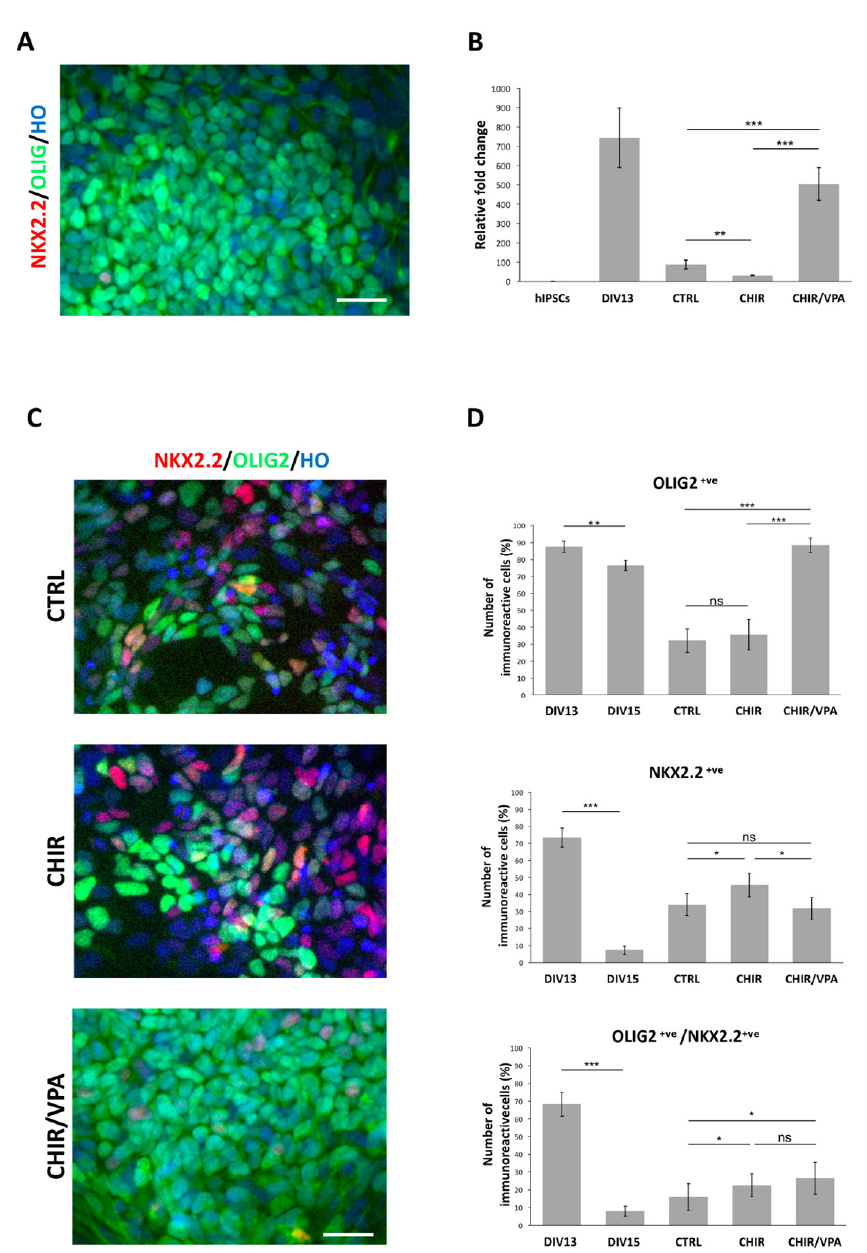
Figure 2. CHIR and VPA treatment allows efficient MNPCs expansion. ( A ) DIV15 MNPCs immunoreactivity for OLIG2 and NKX2.2. Nuclei are stained with Hoechst (HO). ( B ) qPCR analysis for OLIG2 transcript levels in hiPSCs, DIV13 MNPCs and cultures expanded for three passages in CTRL, CHIR and CHIR/VPA conditions. ( C ) Representative pictures showing OLIG2 and NKX2.2 immunoreactivity on cultures expanded for three passages in CTRL, CHIR and CHIR/VPA conditions. Nuclei are stained with Hoechst (HO). ( D ) Graphs reporting the number of OLIG2, NKX2.2 and OLIG2/NKX2.2 double-positive cells (top, central and bottom panel, respectively) in DIV13 and DIV15 MNPCs and cultures expanded for three passages in CTRL, CHIR and CHIR/VPA conditions. The percentage is normalized over the total number of cells assessed by HO staining. Scale bars: 15 μ m. Data are expressed as the means ± STDV ( n = 3 biologically independent experiments). p < 0.05 (*), p < 0.01 (**), and p < 0.001 (***) not significant (ns) according to ANOVA